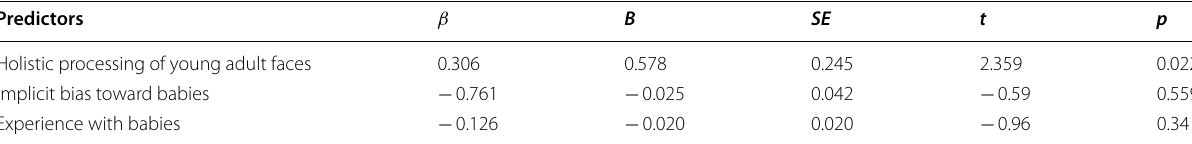
Table 9 Results of the multiple regression analysis on the congruency effect (∆accuracy: accuracy in congruent trials minus accuracy in incongruent trials) in Experiment 2